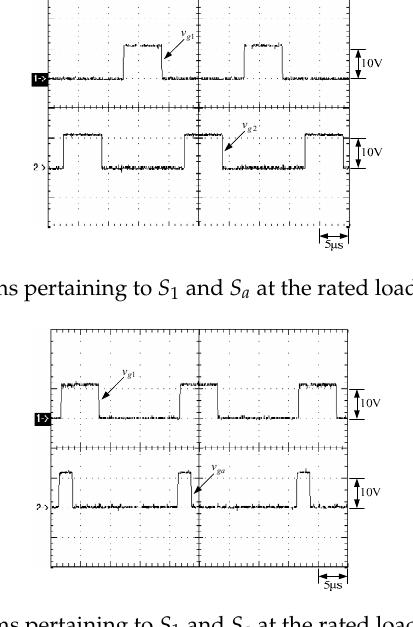
Figure 25. Waveforms pertaining to S 1 and S a at the rated load: (1) v g 1 ; and (2) v ga . Appl. Sci. 2019 , 9 , x FOR PEER REVIEW